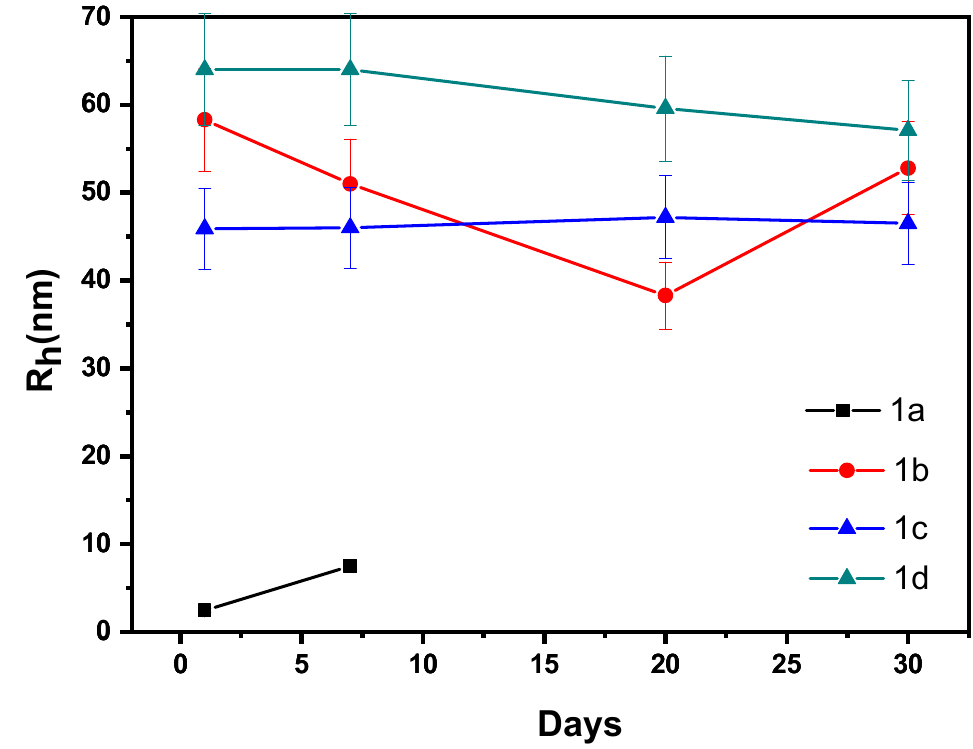
Figure 2. R h values fluctuation for Samples 1a, 1b, 1c, and 1d from day 1 to day 30, as it was obtained from dynamic light scattering measurements.